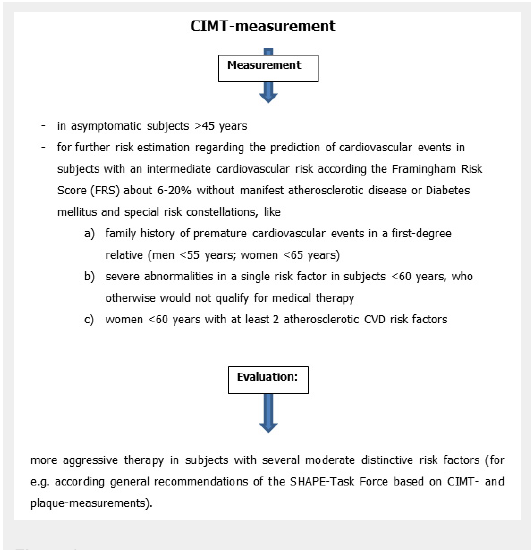
Potential implementation of CIMT-measurements in the daily clinical practice. General recommendation of SHAPE-Task Force